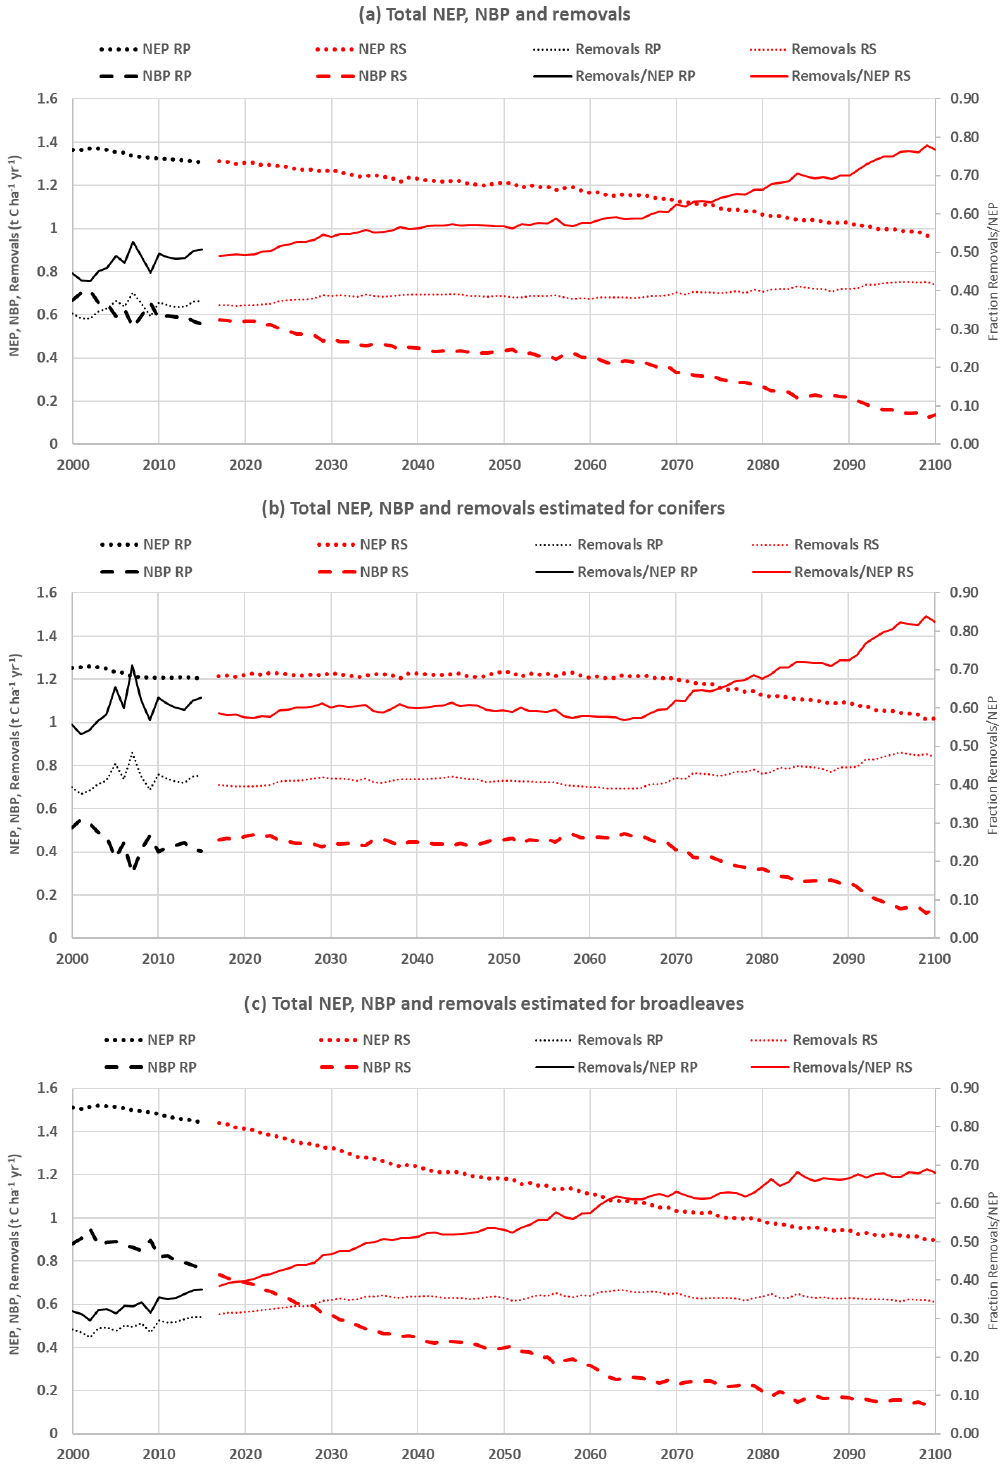
Figure 3. Net ecosystem production (NEP), net biomass production (NBP) and harvest removals (all reported in tCha − 1 yr − 1 on the left axis) estimated within the reference period 2000–2015 (RP) and from 2016 to 2100 under the reference scenario (RS) (a) , further distinguished by conifers (b) and broadleaved species (c) . The figure also reports (see the axis on the right side) the ratio between the amount of harvested material removed and the NEP, as considered within the historical period and from 2016 onwards, assuming the continuation of the current management practices detected within the period